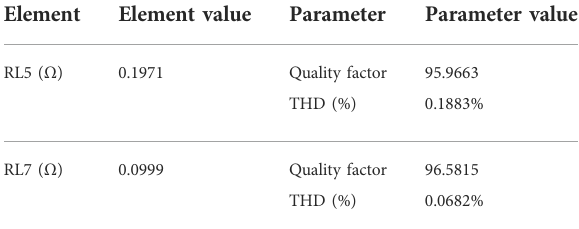
TABLE 1 Performance analysis of the proposed